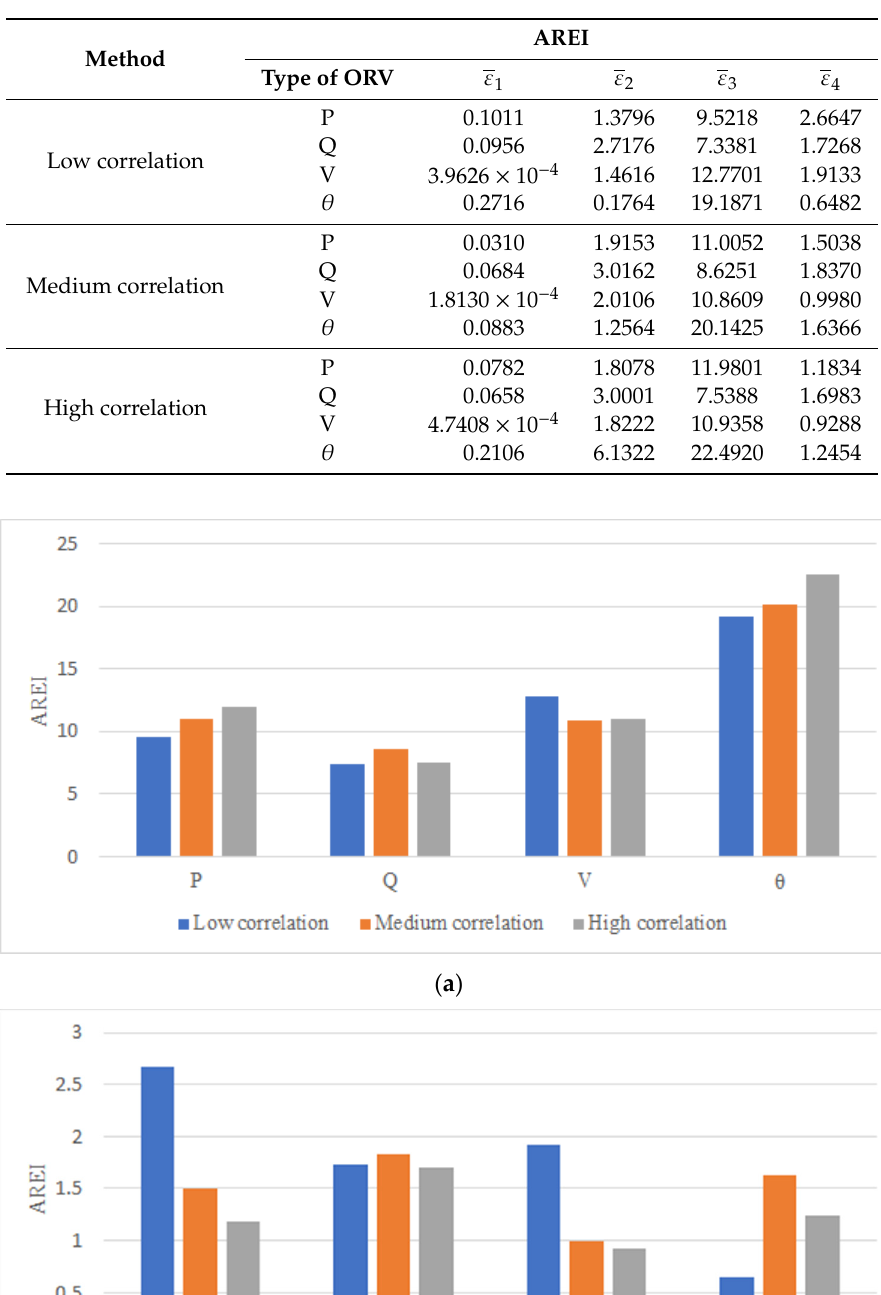
Table 4. Sensitivity to correlation of proposed method.